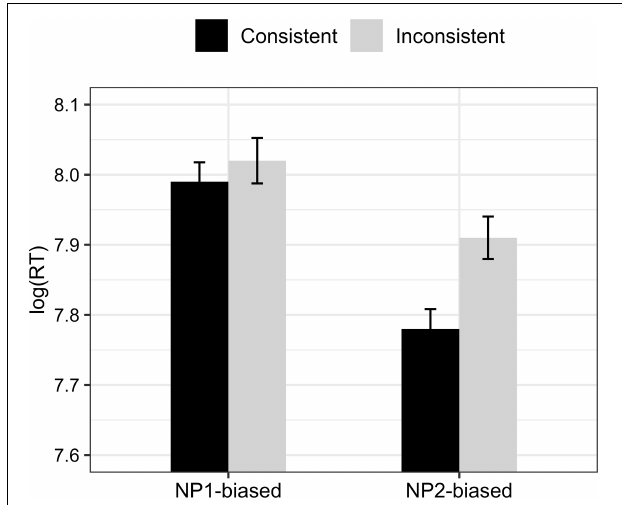
FIGURE 1 | Mean log-transformed response times in each condition of Experiment 1. Error bars represent one standard